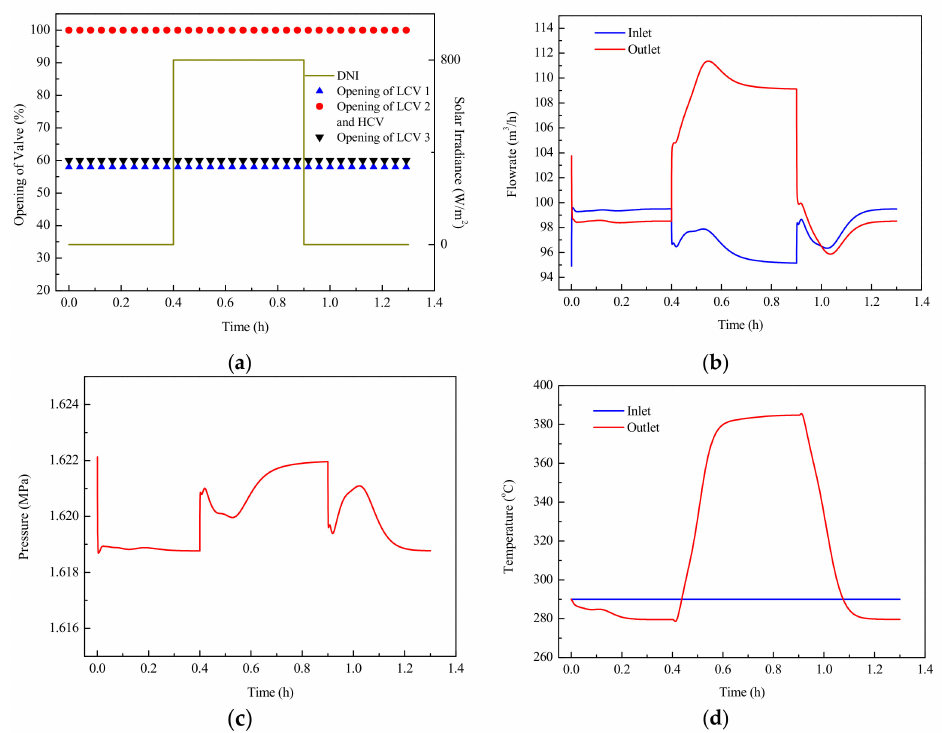
Figure 16. Simulating Case 1 for ( a ) initial parameters, ( b ) inlet and outlet header flow rate results; ( c ) pump pressurizing results, and ( d ) inlet and outlet header temperature